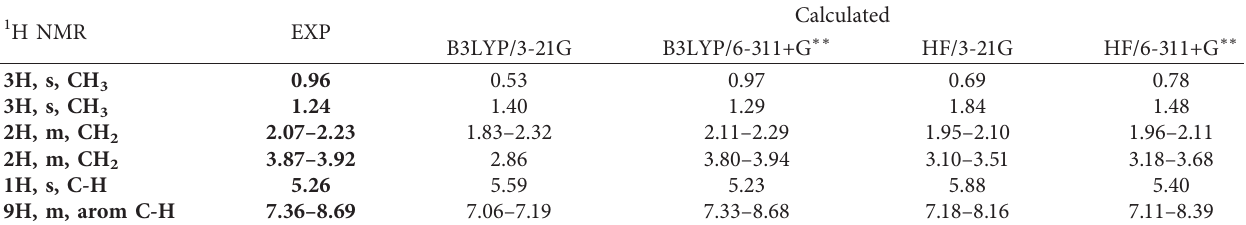
Table 9: Experimentally measured and calculated 1 H chemical shifts δ (ppm vs TMS) of the compound (5c) . 1 H NMR